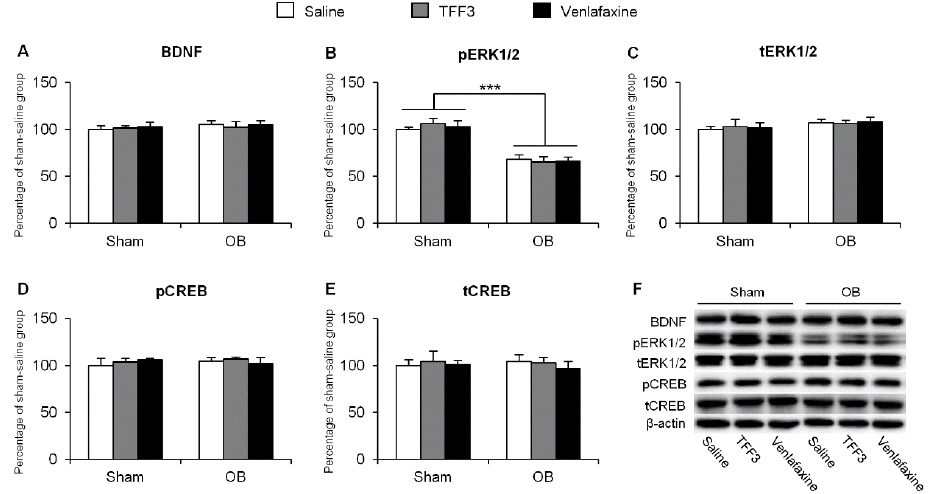
Figure 4. Effects of 7-day TFF3 treatment on BDNF expression and ERK1/2 and CREB phosphorylation in hippocampal DG. The levels of BDNF ( A ); pERK1/2 ( B ); tERK1/2 ( C ); pCREB ( D ) and tCREB ( E ) in DG were detected using Western blot; ( F ) Representative band intensities of the Western blot. The data are expressed as mean ± SEM ( n = 6 per group). *** p < 0.001, compared with sham group.